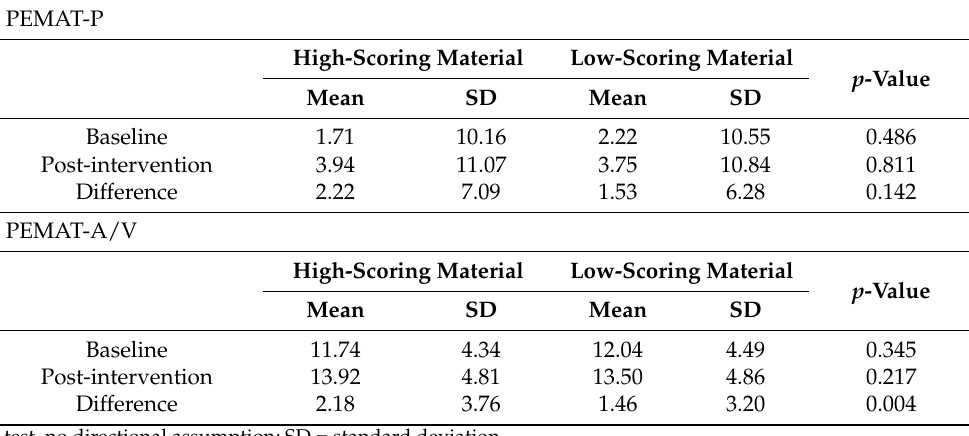
Table 6. Perceived self-efficacy of the